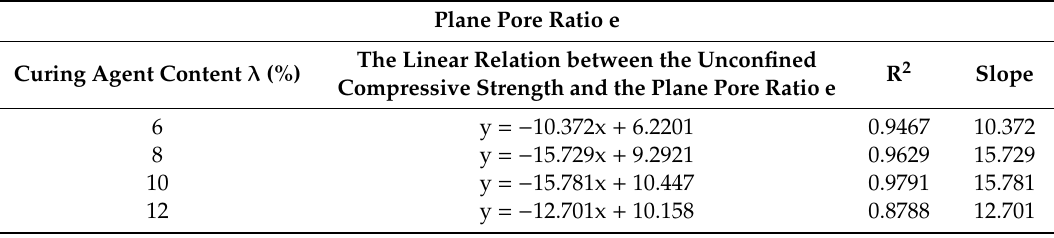
Table 12. Linear relationship between the unconfined compressive strength and the plane pore ratio. Plane Pore Ratio